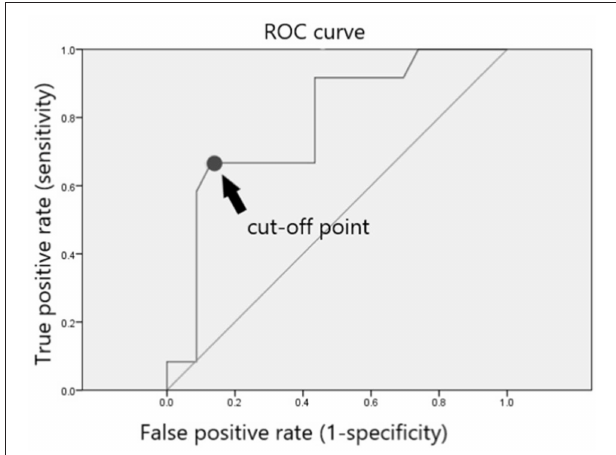
FIGURE 1 | ROC curve and cut-off point for post-RARP PSA value. The ROC curve was presented in this figure. The area under the curve was 0.779 (95% confidence interval, 0.616 to 0.942, P < 0.007) and the cut-off value to prevent BCR was 0.195ng/ml with the sensitivity of 66.7% and specificity of 87%. The Youden’s index (sensitivity + specificity-1) was 0.537.